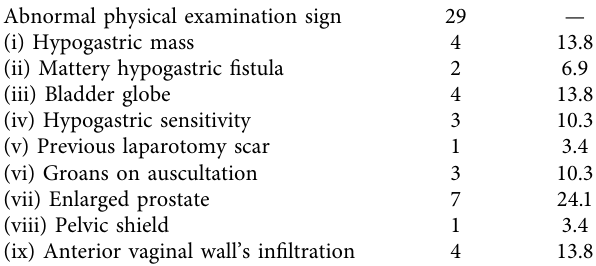
Table 2: Physical examination abnormal